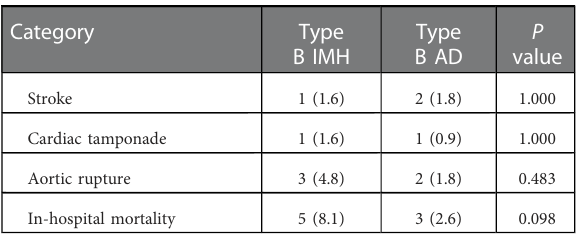
TABLE 1 Clinical characteristics of type B IMH and type B